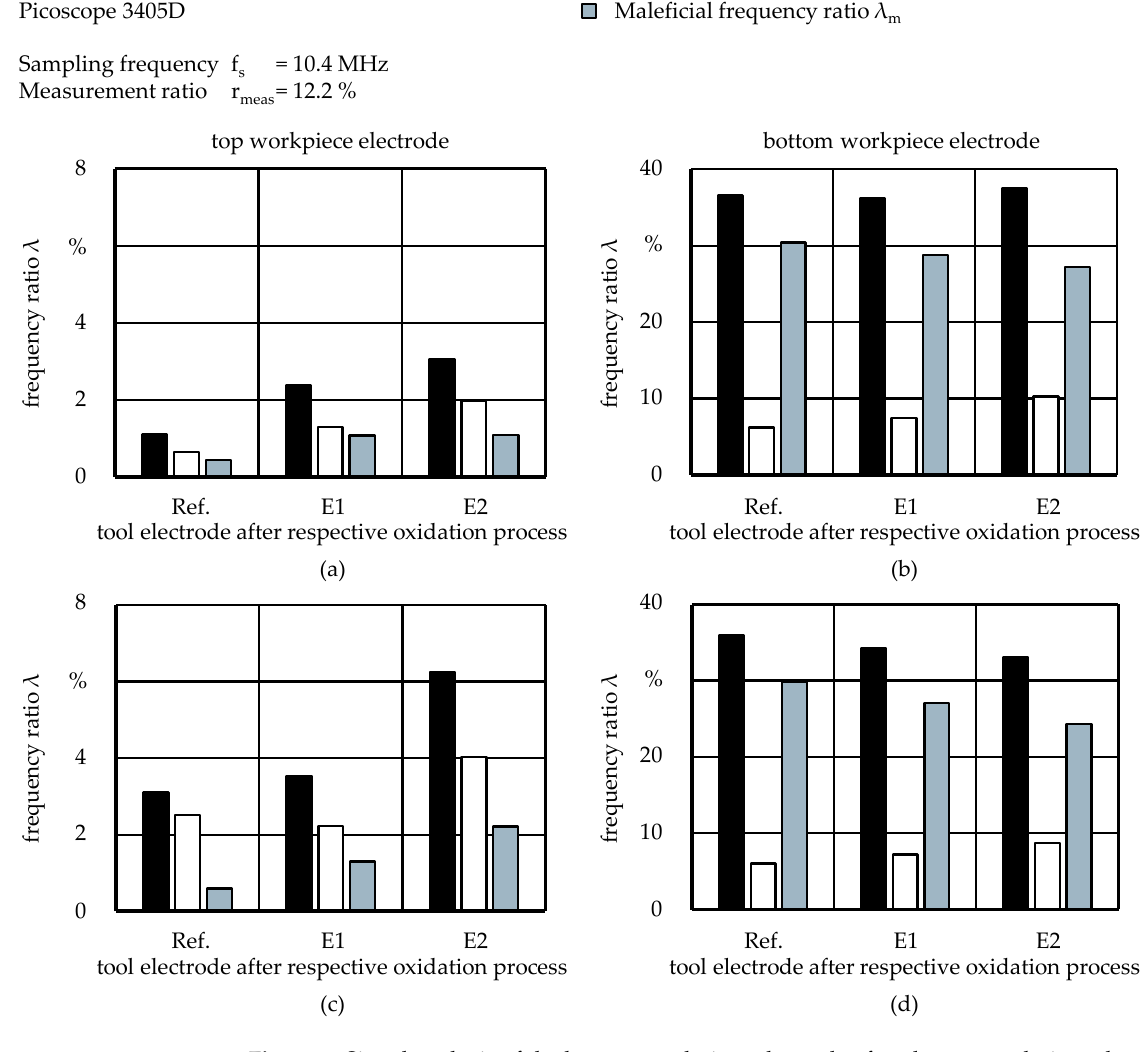
Figure 6. Signal analysis of the bottom workpiece electrode after the top workpiece electrode had been traversed. Events occurring in the top workpiece electrode: ( a ) across the whole duration, ( c ) up to an erosion duration of t ero,start = 2 min; events occurring in the bottom workpiece electrode ( b ) across the whole duration, ( d ) up to an erosion duration of t ero,start = 2 min. Compared to the unoxidized reference tool electrode, the beneficial frequency ratios ( λ b ) caused by contributing discharges in the bottom half of the workpiece electrode both increased, from λ b,(b),Ref = 6.17% to λ b,(b),E1 = 7.44% and λ b,(b),E2 = 10.23%. In addition, the maleficial frequency ratios ( λ m ) caused by arcing and short circuits decreased from λ m,(b),Ref = 30.43% to λ m,(b),E1 = 28.78% and λ m,(b),E2 = 27.24%. Both phenomena led to a decrease in the erosion duration (t ero ) for the oxidized tool electrodes presented in Figure 5, potentially caused by the lower electrical resistivity ( ρ ) of the base tool electrode and the oxide layer protecting against lateral discharges. Both resulted in more effective frontal discharges and thus in a lower erosion duration (t ero